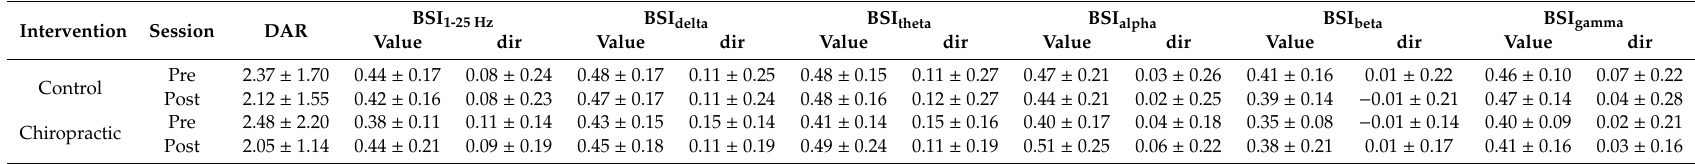
Table 2. DAR and BSI descriptive